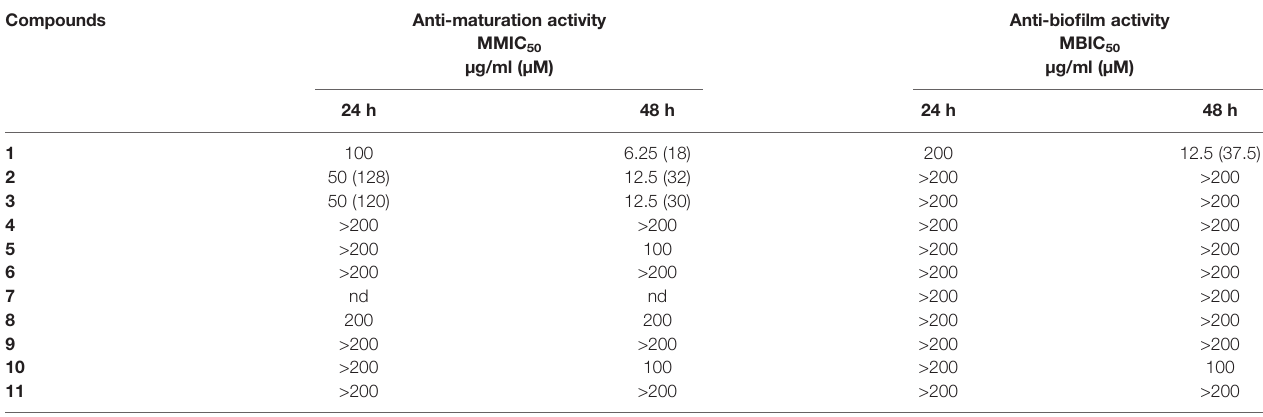
TABLE 1 | Anti-maturation and anti-bio fi lm activities of 11 lichen compounds against Candida albicans expressed as 50% inhibitory concentration ( p < 0.05) at 24 and 48 h of treatment. IC 50 is expressed in micromolar for values <100 µg/ml. Compounds